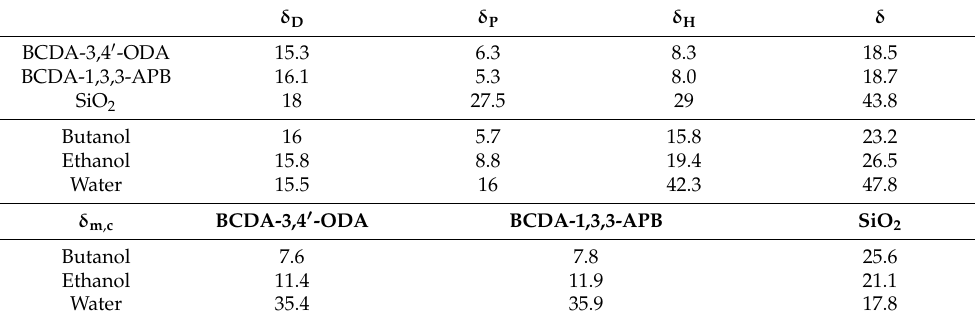
Table 3. Values of Hansen solubility parameters for alicyclic PIs, SiO 2 , and three solvents. δ D